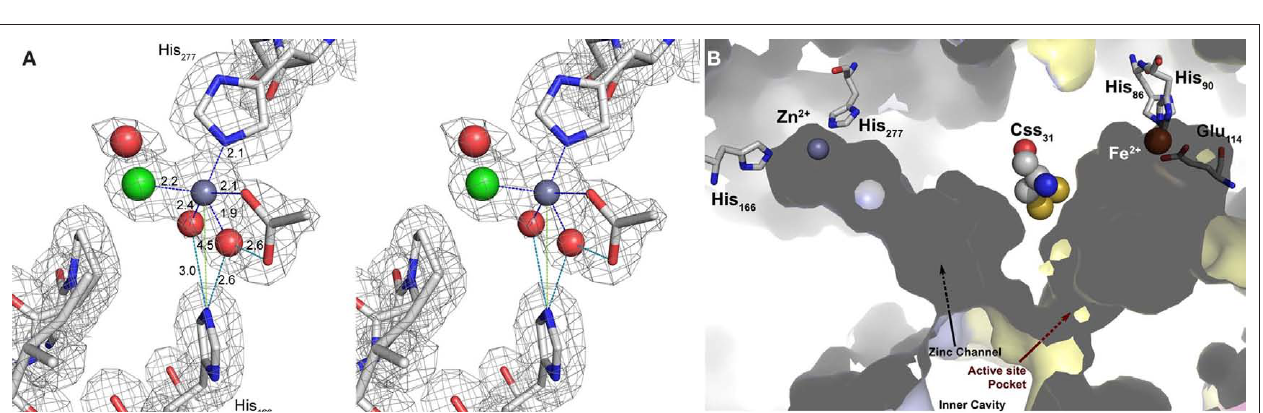
the Zn 2 + coordinating waters; light green dashes, non-bonding distances; FiguRe 6 | The Zn 2 + -binding site. (A) Electron density at the Zn 2 + -binding site (gray mesh representing 2m|Fo| − D|Fc| map at 1 σ ). Cross-eyes stereo image sticks representation: carbon in gray, nitrogen in blue, oxygen in red. showing the Zn 2 + ion coordination (dark gray sphere with blue dashed lines) (B) Surface representation of two neighboring monomers (light blue and yellow) highlighting the positions of the Zn and Fe sites with their respective with the His side chain, one acetate ion (ACT), one chloride ion (green 277 ligands and channels and the bridging cysteine persulfide. The zinc site is sphere), and two waters (red spheres) that are also at hydrogen-bonding located at the end of a tunnel leading to the active site Css distances (cyan dashed lines) from N ε 2 of the His side chain. The other 166 acetate oxygen is at hydrogen-bonding distance (cyan dashed line) from one of neighboring